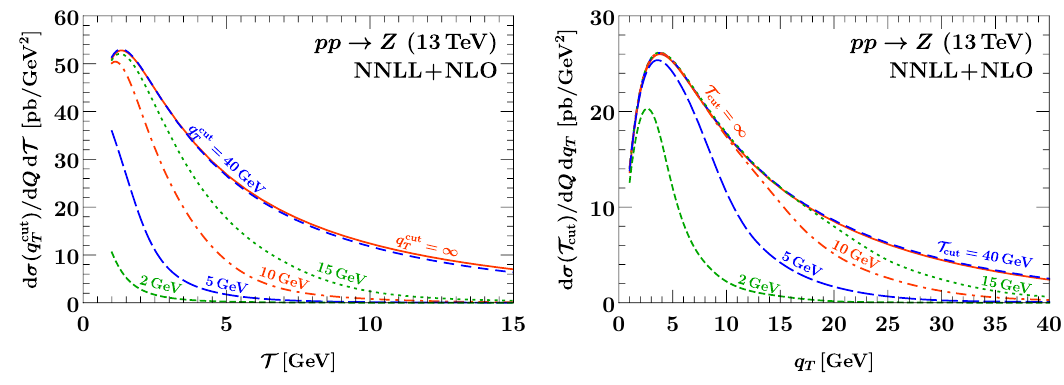
Figure 20 . The single-di(cid:11)erential T (left) and q T (right) spectrum with a cut on the other variable at NNLL+NLO. The di(cid:11)erent curves represent di(cid:11)erent values of the cut. The solid orange lines correspond to the inclusive single-di(cid:11)erential spectrum obtained by lifting the